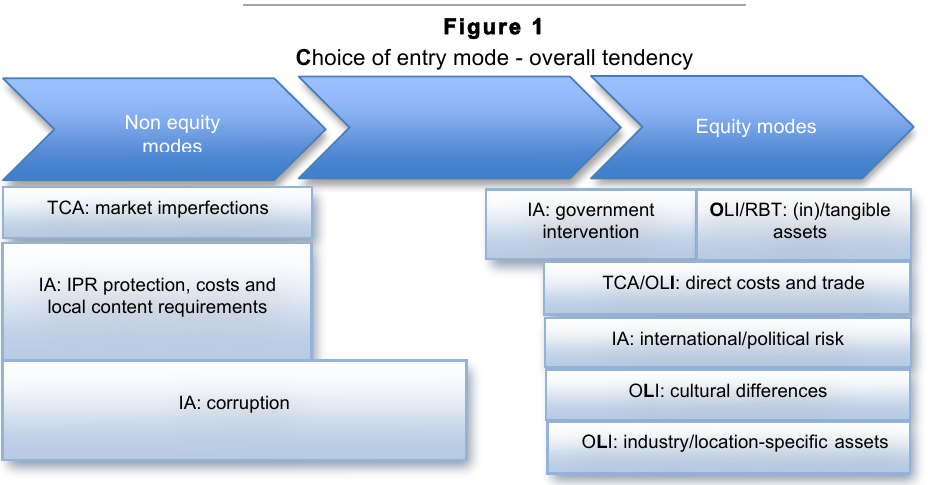
C hoice of entry mode - overall